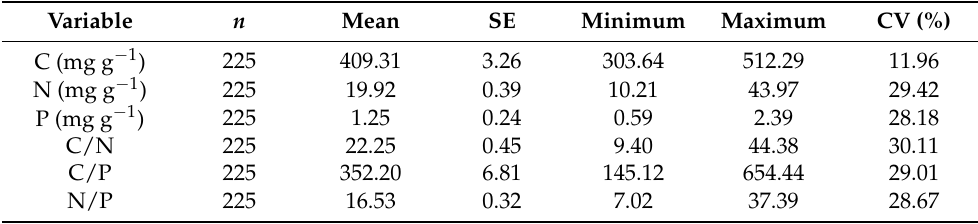
Table 1. The overall descriptive statistical characteristics of C, N, P stoichiometric characteristics of desert saline shrub